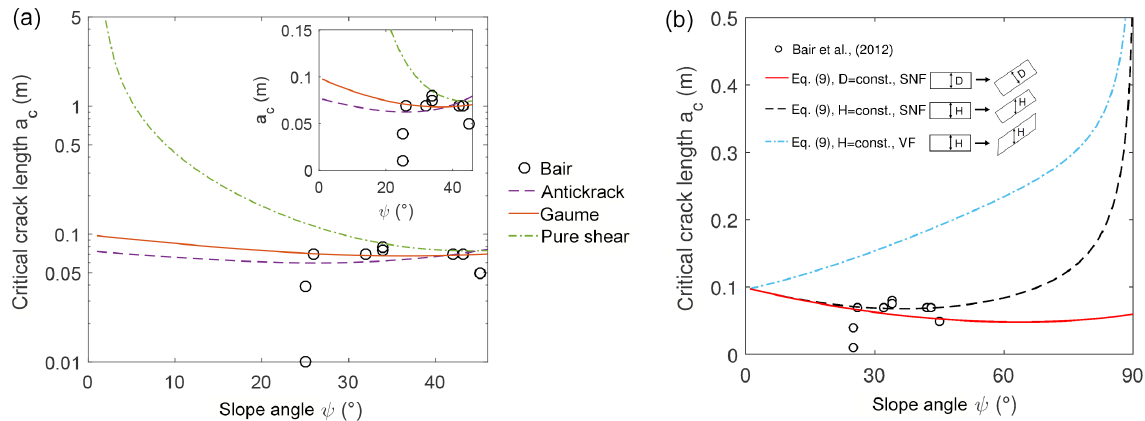
Figure 8. (a) Critical crack length vs. slope angle: comparison between the data of Bair et al. (2012) (black circles) and our new model (Eq. 9, red line), the anticrack model (purple dashed-line), and a pure shear model (Eq. 7, green dotted line) for a constant slab depth H = 0 . 35m ( D = H cos ψ ) and the same input parameters as in Bair et al. (2012) with a semi-log scale. The cohesion c = 500Pa was estimated based on the hand hardness index provided in Bair et al. (2012) using the parametrization by Geldsetzer and Jamieson (2001) and Jamieson and Johnston (2001). Inset: linear scale. (b) Effect of geometry on the slope angle dependency for the PST. SNF: slope normal faces; VF: vertical faces; const.: